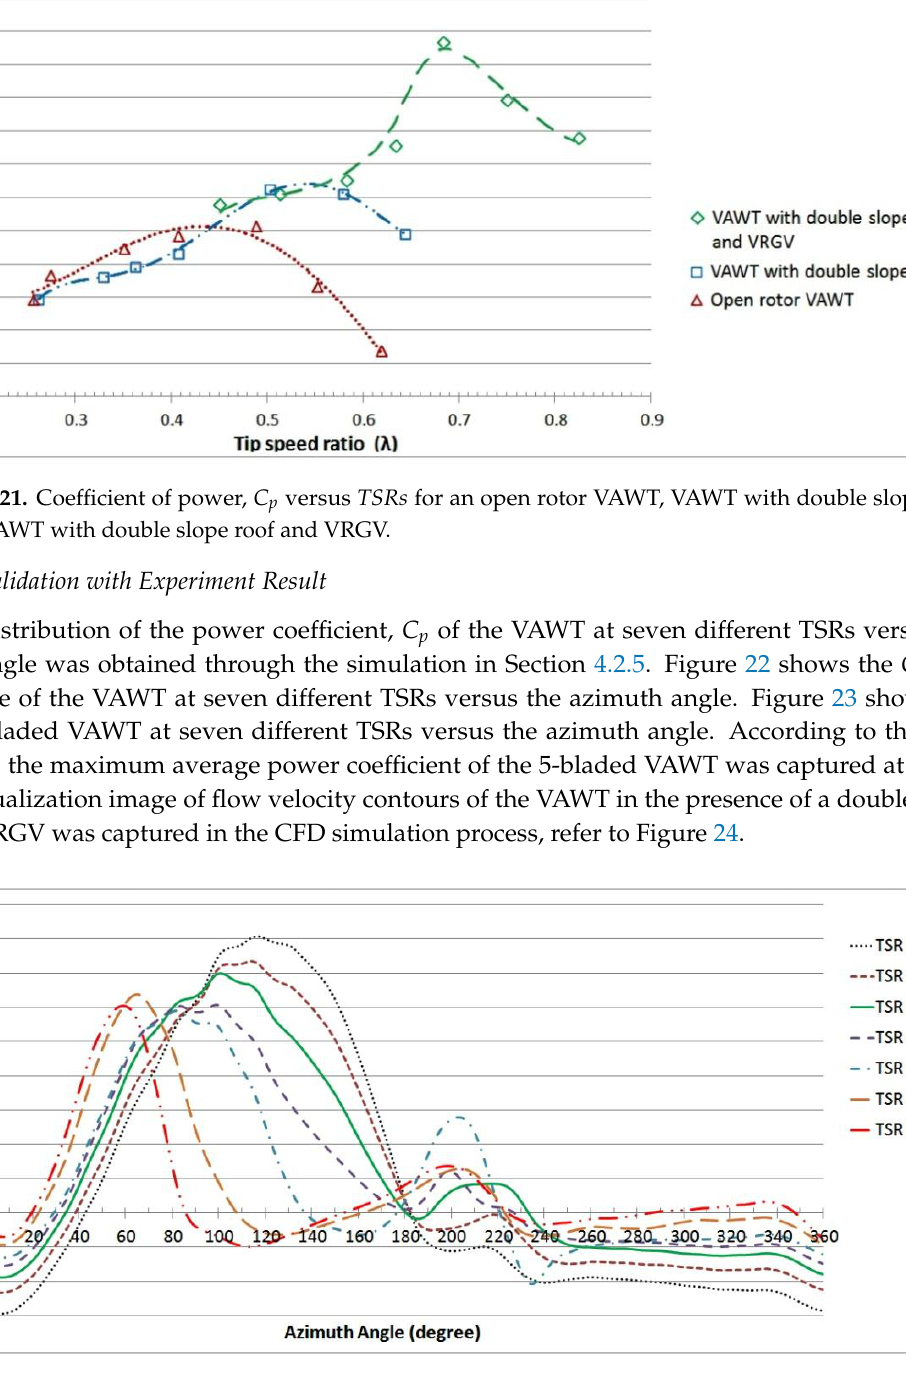
Figure 23. Power coefficient of a 5-bladed VAWT versus azimuth angle.